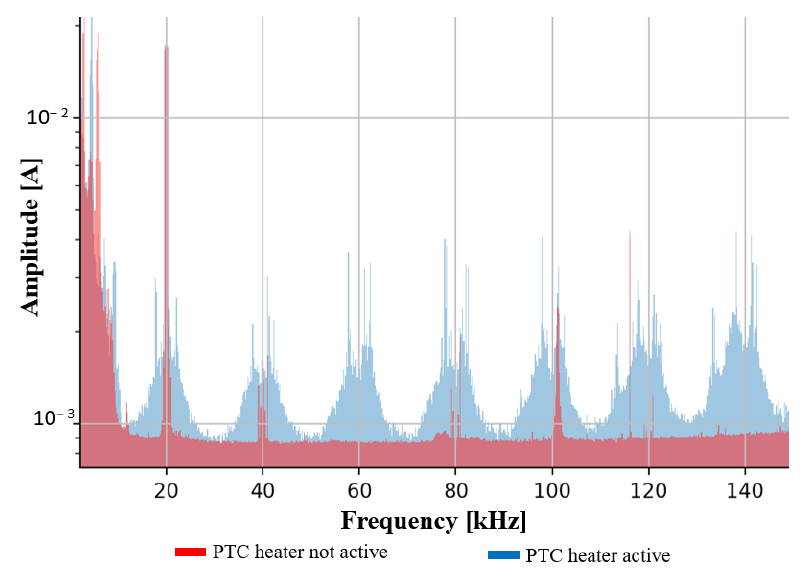
Figure 12. Supraharmonic emissions with (blue) and without (red) active PTC heater.